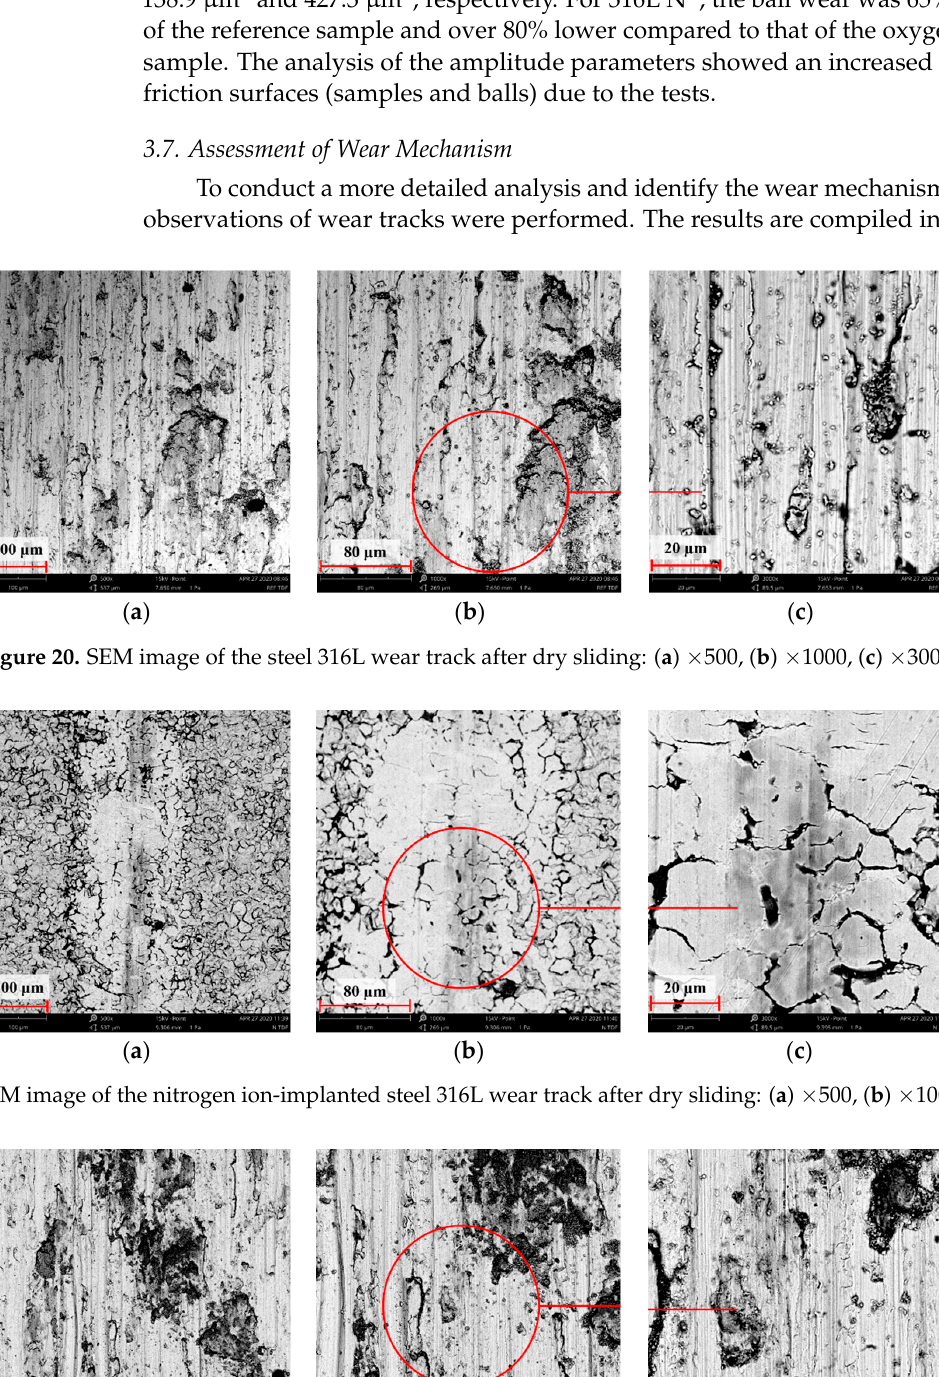
( c ) Figure 23. SEM image of the steel 316L wear track after RS-lubricated friction: ( a ) ×500, ( b ) ×1000, ( c ) ×3000. ( a ) ( c ) Figure 24. SEM image of the nitrogen ion-implanted steel 316L wear track after friction with RS lubrication: ( a ) ×500, ( b ) ×1000, ( c ) ×3000.